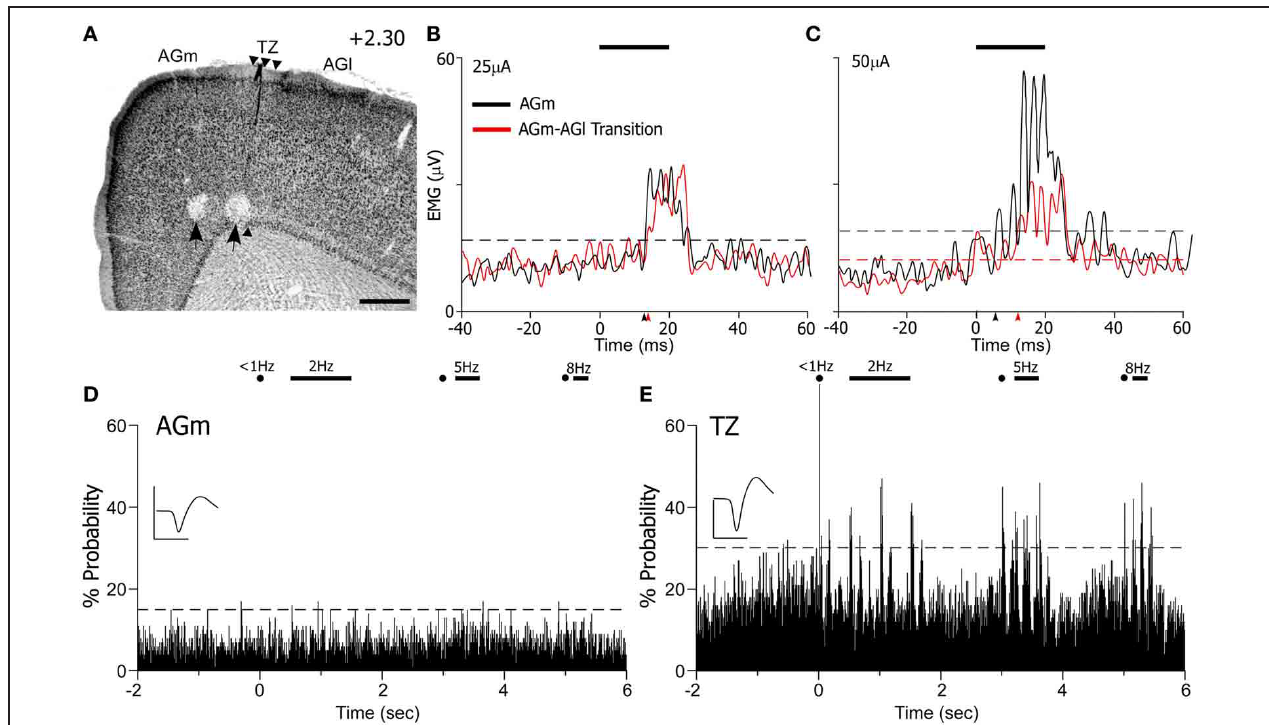
or the transition zone. Each graph represents the mean of 10 trials. Arrowheads indicate onset of EMG response; dashed lines represent maximum pre-stimulus activity. (D,E) PSTHs illustrate sensory-evoked responses as in Figure 9 . Waveform scales: 200 μ V and 1ms. PSTH bins: